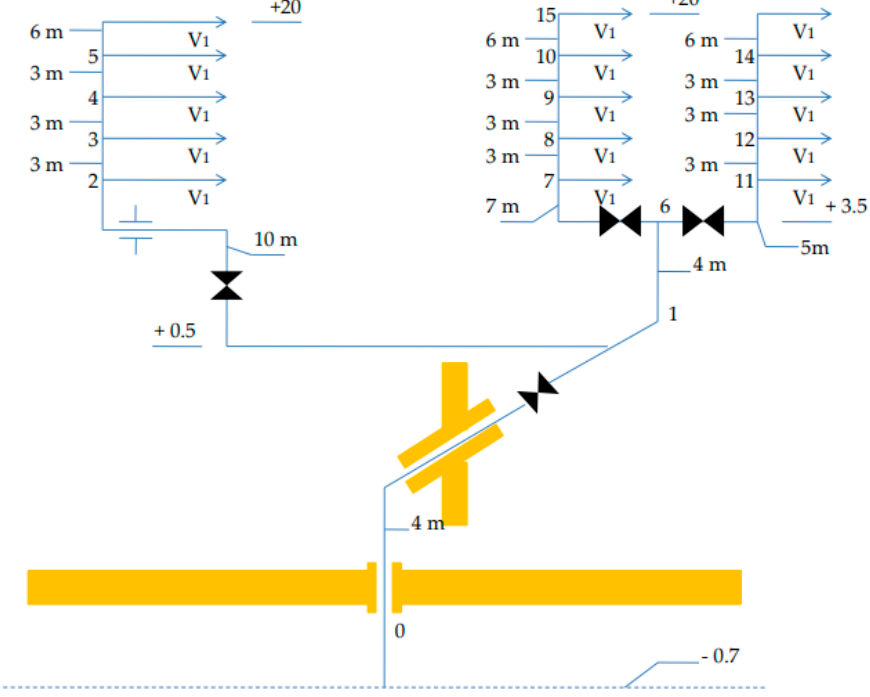
Figure 4. The calculation scheme of the gas pipeline. Table 4. Emergency mode at area 1 (Refusal at area 1).